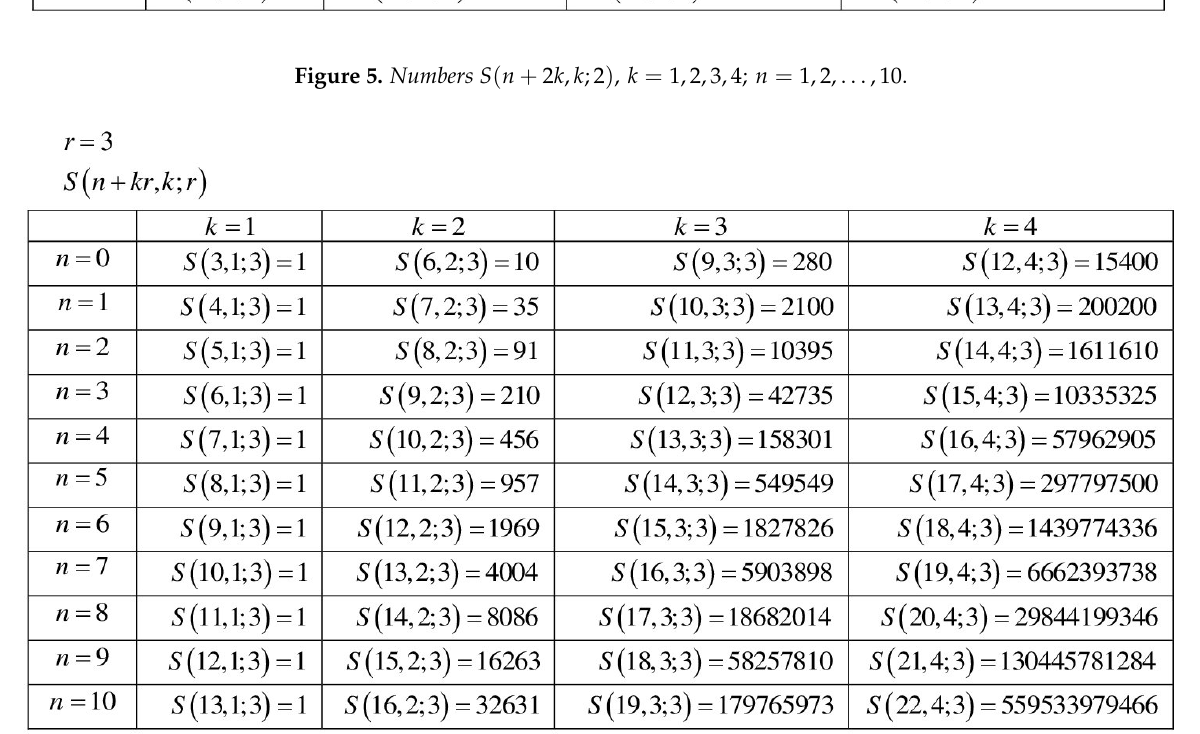
Figure 6. Numbers S ( n + 3 k , k ;3 ) , k = 1,2,3,4; n = 1,2, . . .